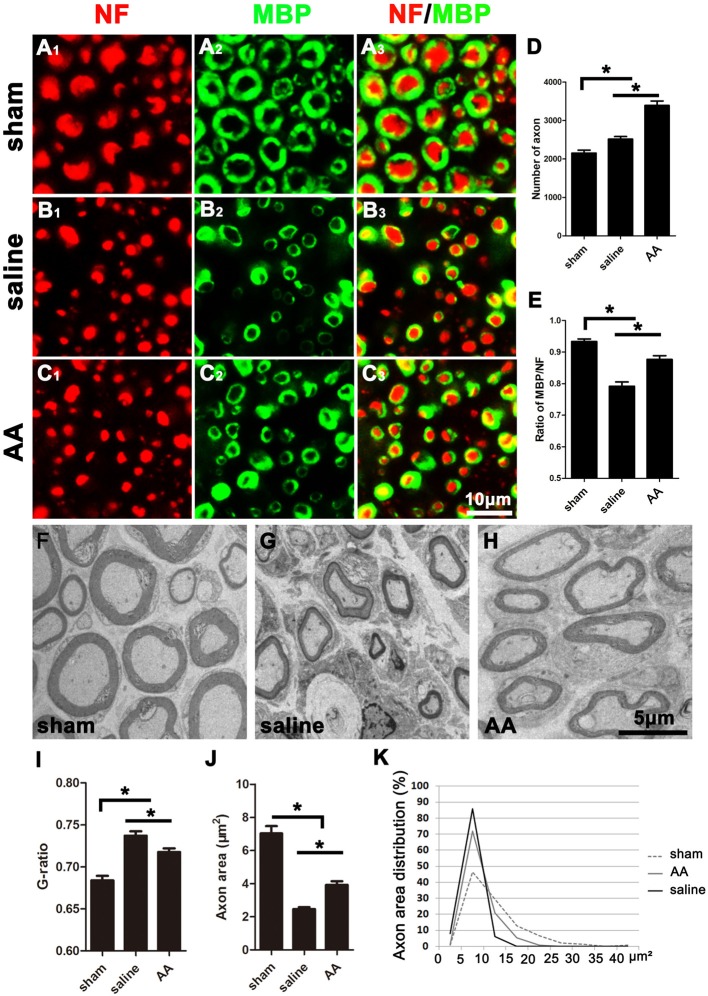
NF (Neurofilament, red) and MBP (Myelin Basic Protein, green) double immunohistochemistry and transmission electron microscopy (TEM) illustrating that AA enhances axonal regeneration and remyelination in the distal portion of the injured sciatic nerve at 28 dpi. Representative samples from (A1–A3) the sham group, (B1–B3) saline group, and (C1–C3) AA group. (D) The number of NF-positive axons in the cross-sections of the nerves (n = 6, *P < 0.05). (E) The MBP/NF ratio of myelinated axons from each group (n = 6, *P < 0.05). (F–H) Representative TEM images showing the axons and their myelin sheaths. (I–K) Quantification of the G-ratio (I), the axonal area (J), and the axonal area distribution (K; n = 4, *P < 0.05).